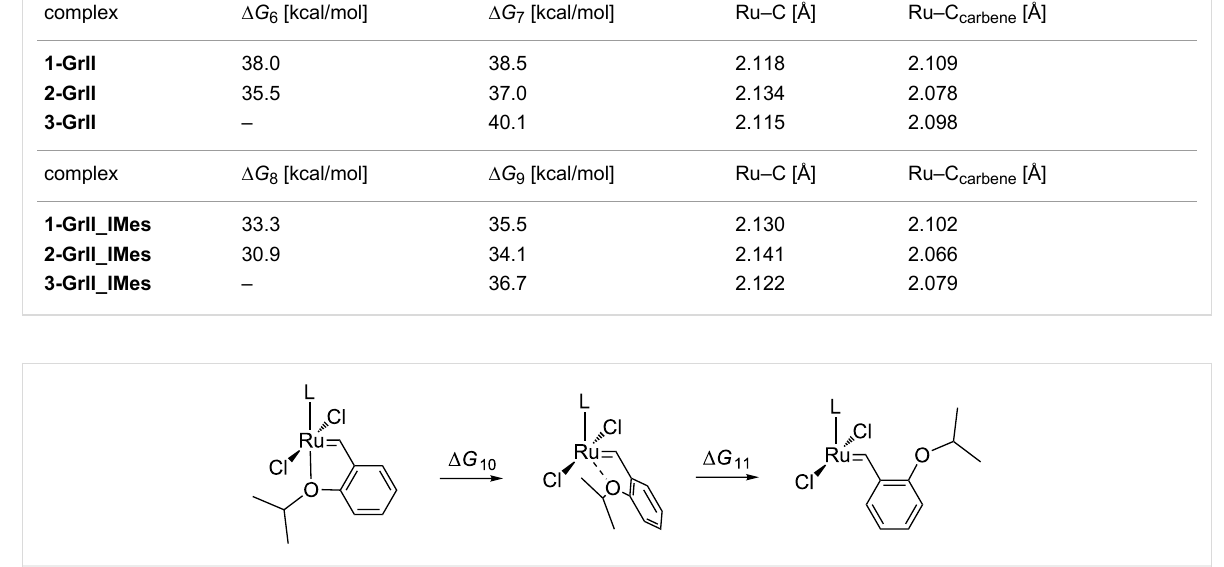
Table 3: The comparison of Gibbs free energies ∆ G 6 – ∆ G 9 and structural parameters of investigated compounds. complex